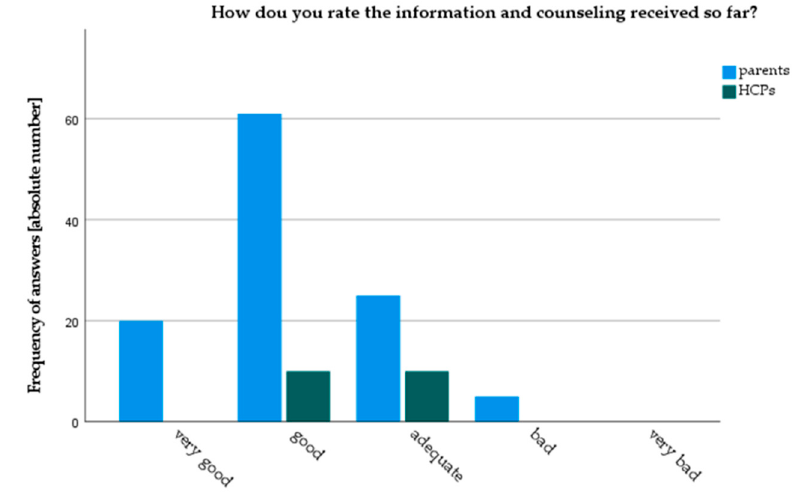
Figure 2. Rating of current counseling practice by parents and HCPs.